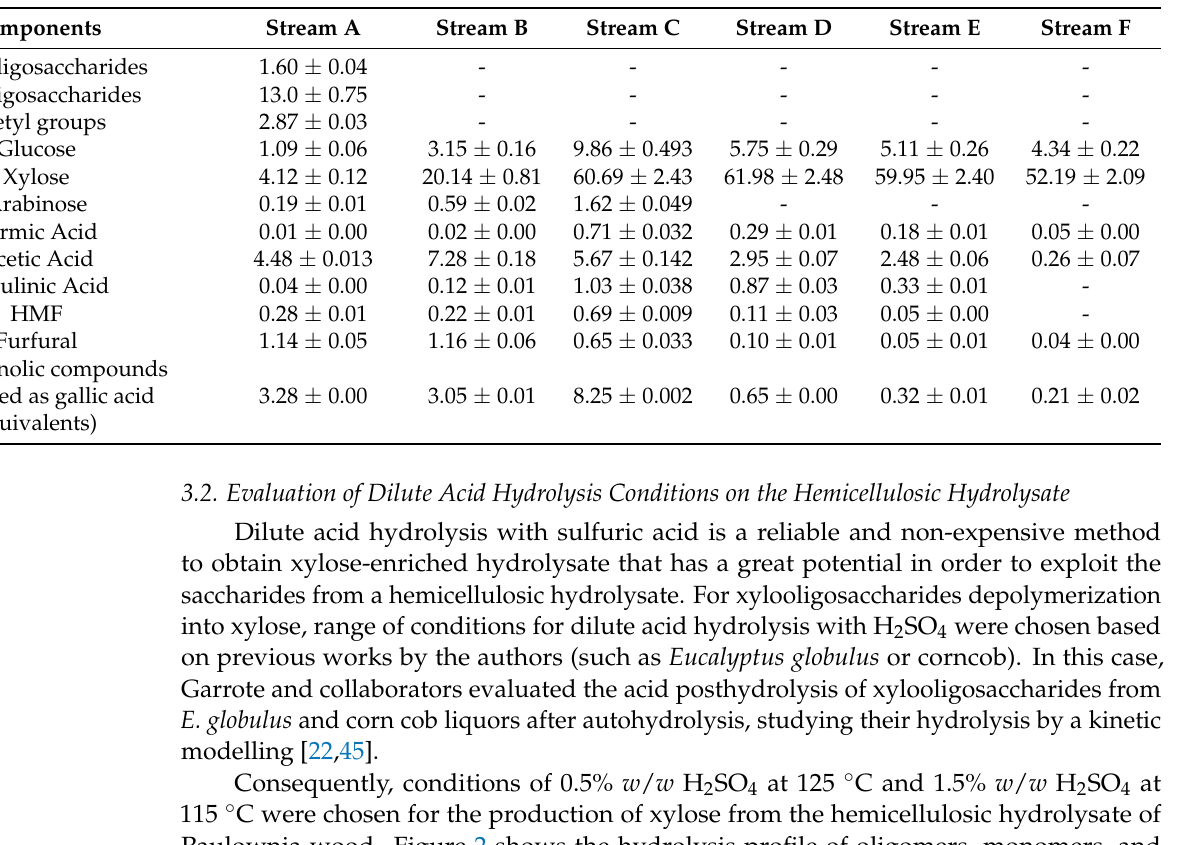
Table 1. Chemical composition in g/L of autohydrolysis liquor (stream A), and hydrolysate after evaluation of acid posthydrolysis (stream B), vacuum evaporation concentration (stream C), overliming (stream D), activated charcoal (stream E) and ion exchange (stream